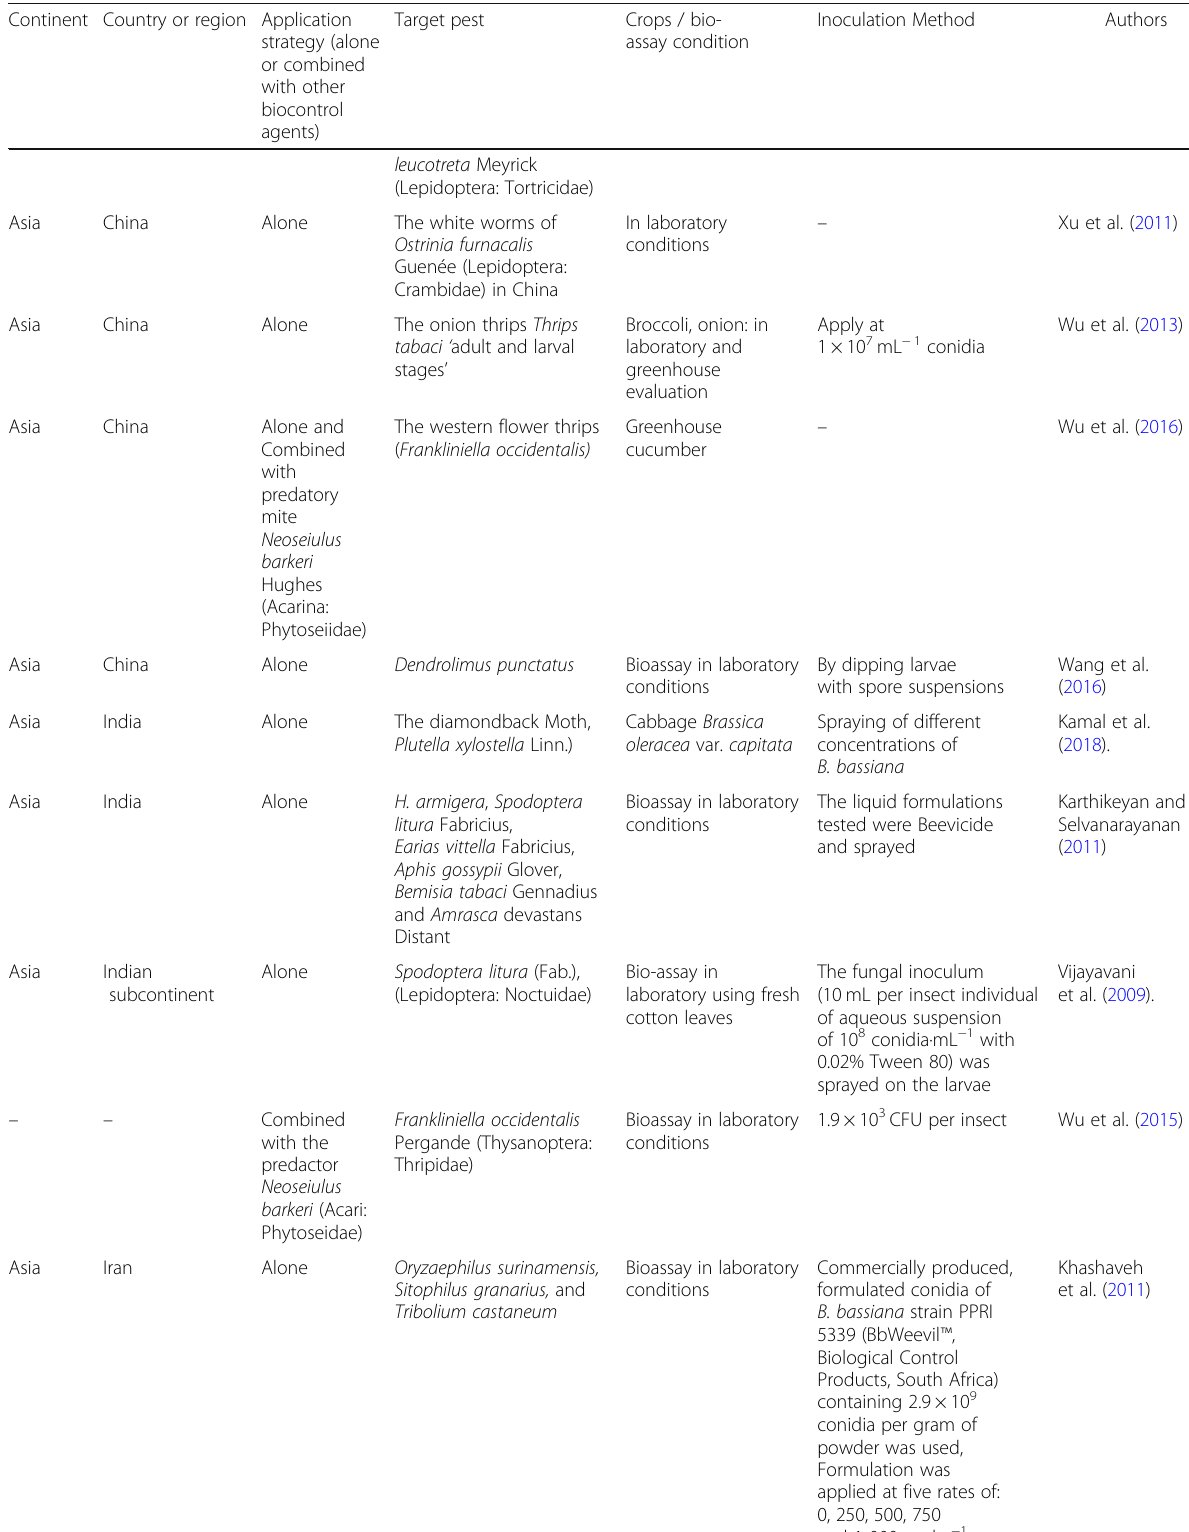
Table 1 Summary of the control programs that successfully used Beauveria bassiana for crop protection from 2009 to 2019 (Continued) Continent Country or region Application strategy